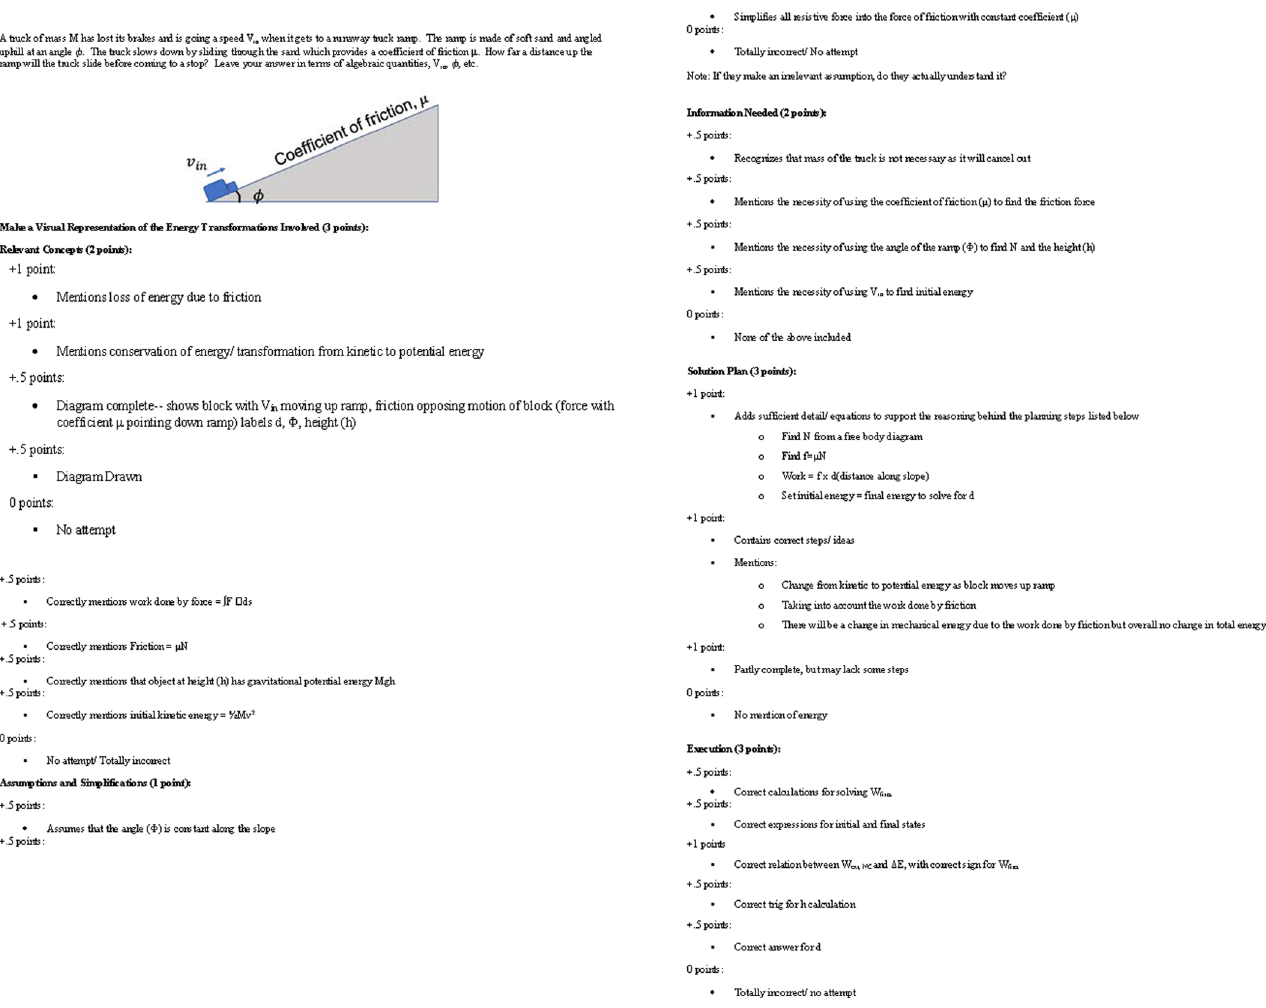
FIG. 9. Rubric for truck problem, part